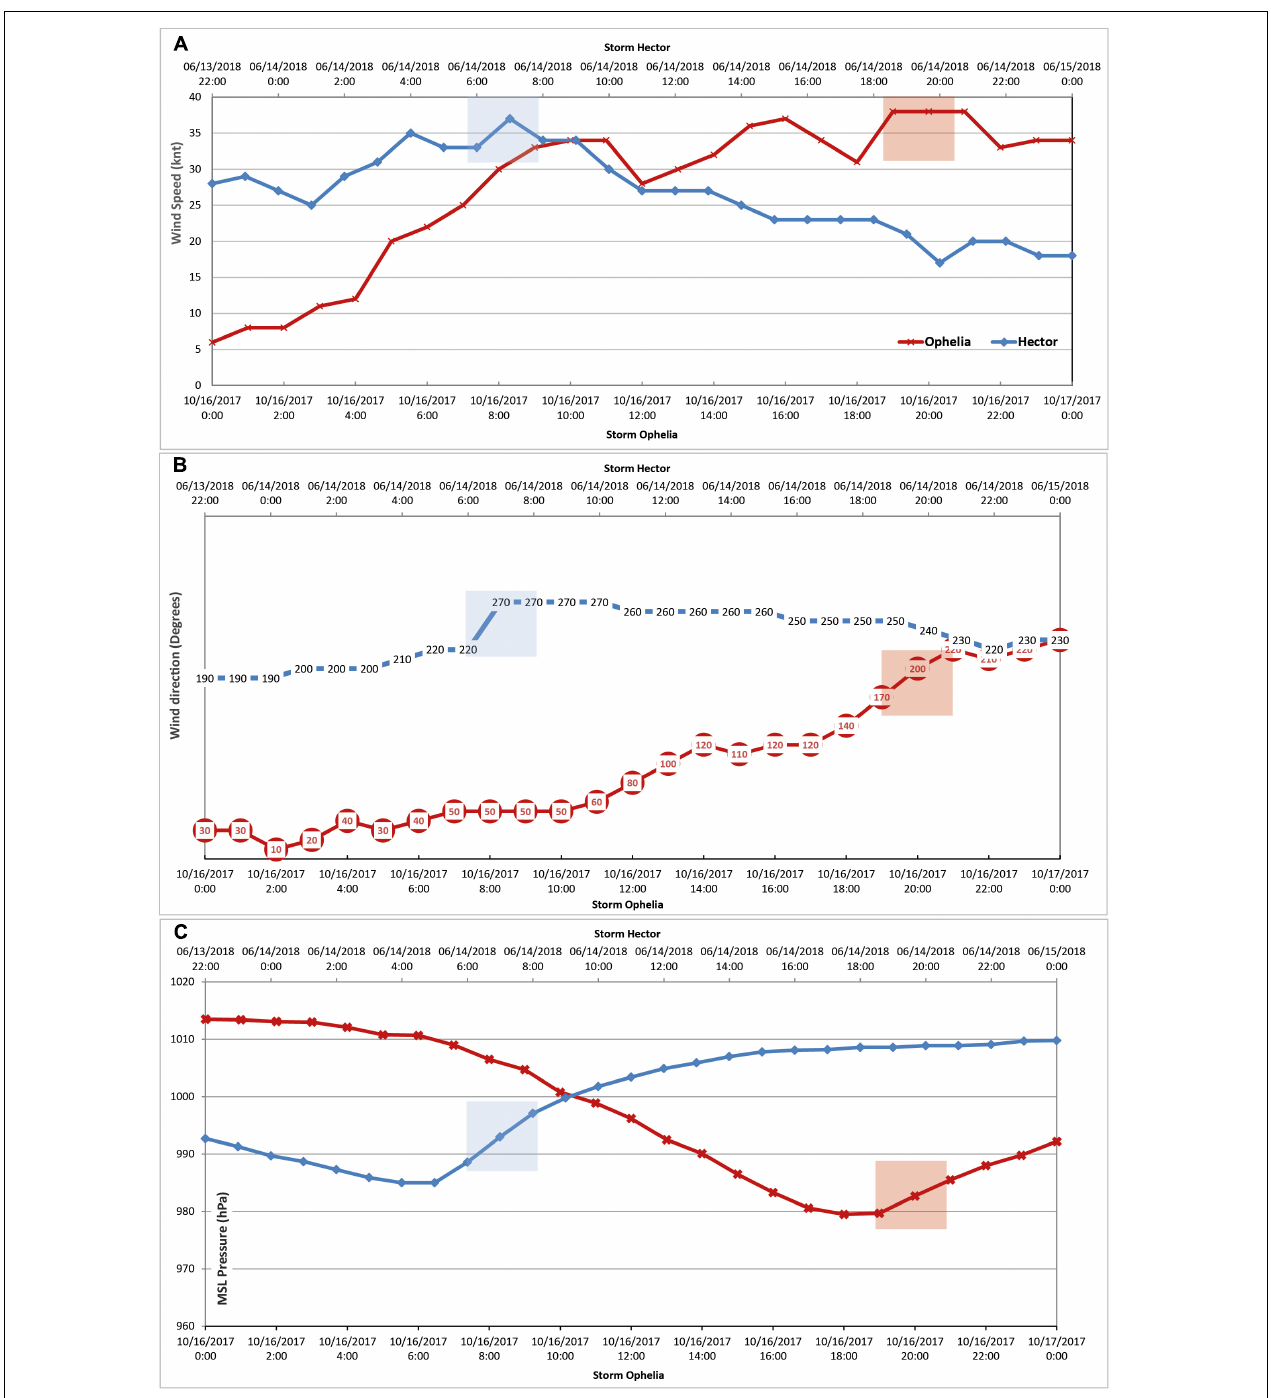
FIGURE 4 | Time-series of wind conditions during both storm events at Malin Head Station. From above (A) 10-min wind speed (knots), (B) wind direction (degrees) and (C) Mean sea level pressure (hPa). Red and blue boxes represent Storm Ophelia and Storm Hector coincidence at Five Finger Strand respectively.